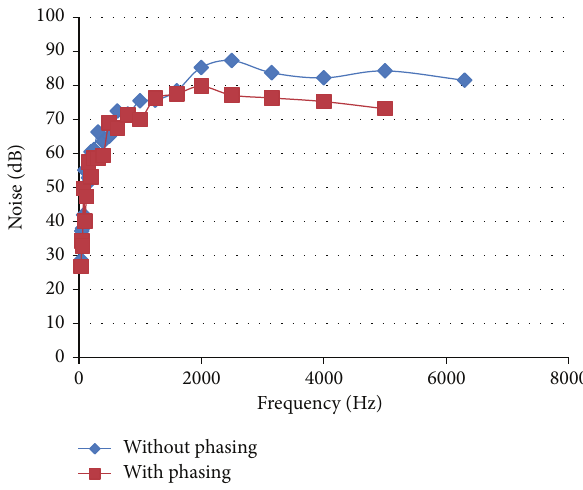
Figure 16: Variation of noise (dB) with frequency (Hz) at 1200rpm at 5kg load.